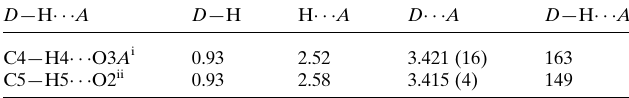
Table 1 Hydrogen-bond geometry (A˚ , (cid:3) ).